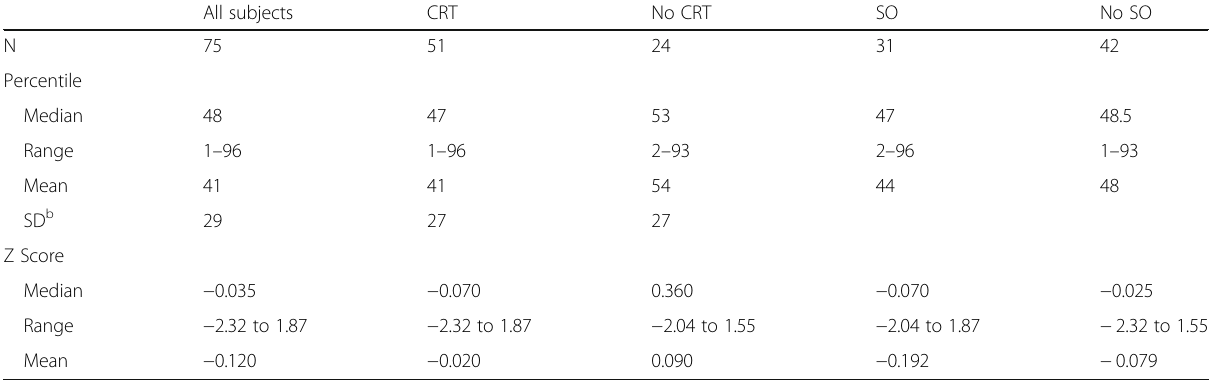
Table 1 Height percentiles and Z scores according to CRT a and sarcopenia obesity (SO)